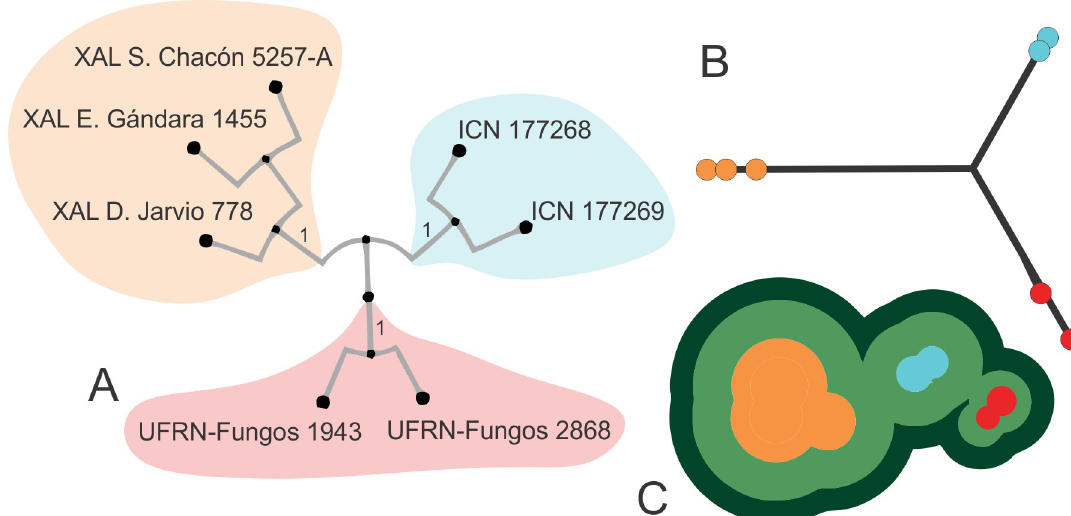
Fig 2. Species delimitation for Blumenavia rhacodes , B . heroica sp. nov. and B . baturitensis sp. nov. (A) Phylogenetic tree obtained by Bayesian analysis on concatenated five loci dataset using MrBayes. (B) bPTP PhyloMap [40] based on Bayesian analysis. (C) Topo- phylogenetic representation [41] of Bayesian analysis. Blumenavia rhacodes specimens: ICN 176968, ICN 177266; B . heroica sp. nov. specimens XAL S. Chaco´n 5257-A, (paratype), XAL E Ga´ndara 1455 (holotype), XAL D. Jarvio 778 (paratype), B . baturitensis sp. nov. specimens: UFRN-Fungos 1943 (paratype), UFRN-Fungos 2868 (holotype).